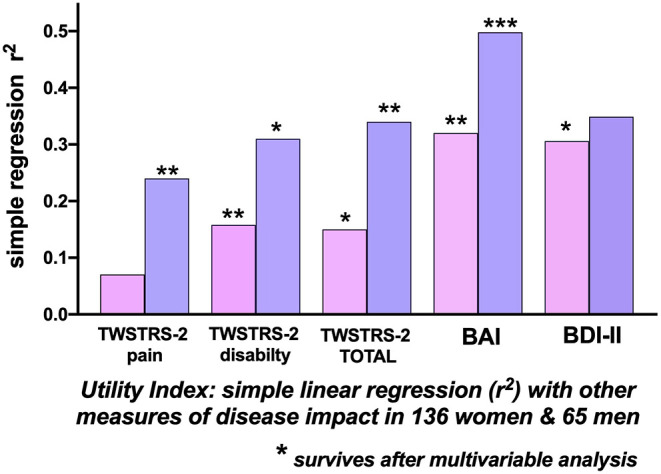
Correlations with the Utility Index as a measure of Quality of Life. Simple linear regression (r-squared) associations of the Utility Index with other measures of disease impact in 136 women (pink bars) and 65 men (blue bars) with cervical dystonia. The height of the bars indicates the univariate r-squared relationship between the Utility Index and the clinical measure. In 136 women, the TWSTRS-2 Total, TWSTRS-2 Disability subscale, Beck Anxiety Inventory, and Beck Depression Inventory (BDI-II) correlations survived multi-variable analysis. In 65 men there were significant separate correlations, surviving multi-variable analysis, between the Utility Index and the TWSTRS-2 Total, TWSTRS-2 Pain, and Disability subscales and with the Beck Anxiety Inventory (BAI). [TWSTRS, Toronto Western Spasmodic Torticollis Rating Scale; BAI, Beck Anxiety Inventory; BDI-II, Beck Depression Inventory; (*p < 0.05; **p < 0.01; ***p < 0.001.